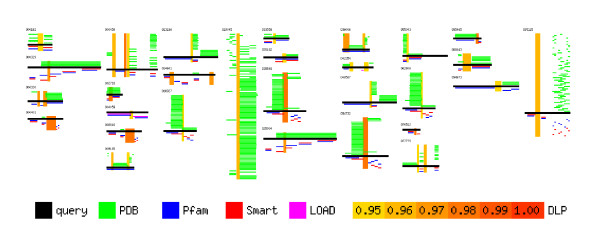
Putative domain linkers and low-complexity regions assigned in SWISSPROT sequences. Each thick black horizontal bar represents a SWISSPROT sequence used as a test sequence. The SWISSPROT ID number is indicated on the top left of the corresponding sequence. In each SWISSPROT sequence, sequence regions similar to PDB and CDD sequences were assigned as putative structural domains. A green horizontal bar represents a sequence region similar to a PDB sequence. Similarly, the horizontal bars colored in blue, red and magenta represent sequence regions similar to CDD sequences, corresponding to the Pfam, SMART and LOAD (Library Of Ancient Domains) libraries, respectively. Sequence regions predicted to be putative domain linkers are designated by vertical bars in colors ranging from yellow to brown, according to the neural network output values. Low-complexityregions are designated by cyan rectangles overlaid on black bars.